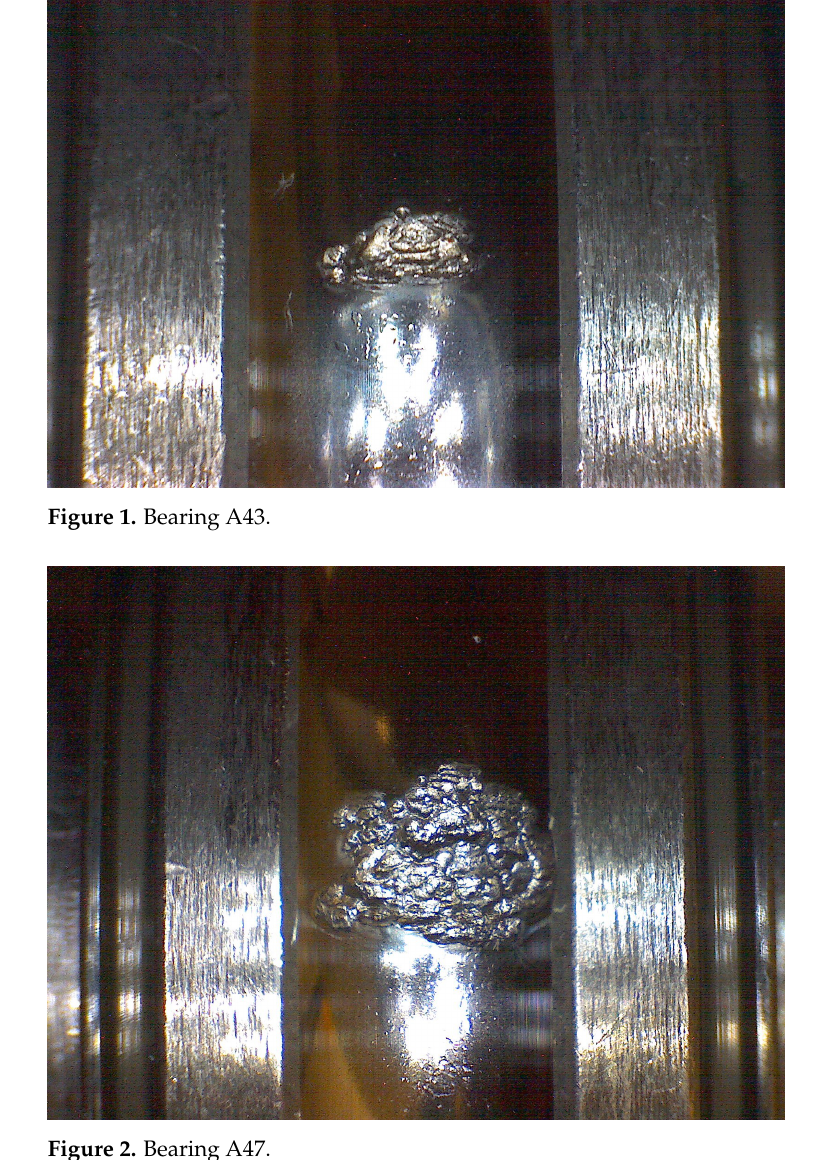
Figure 2. Bearing